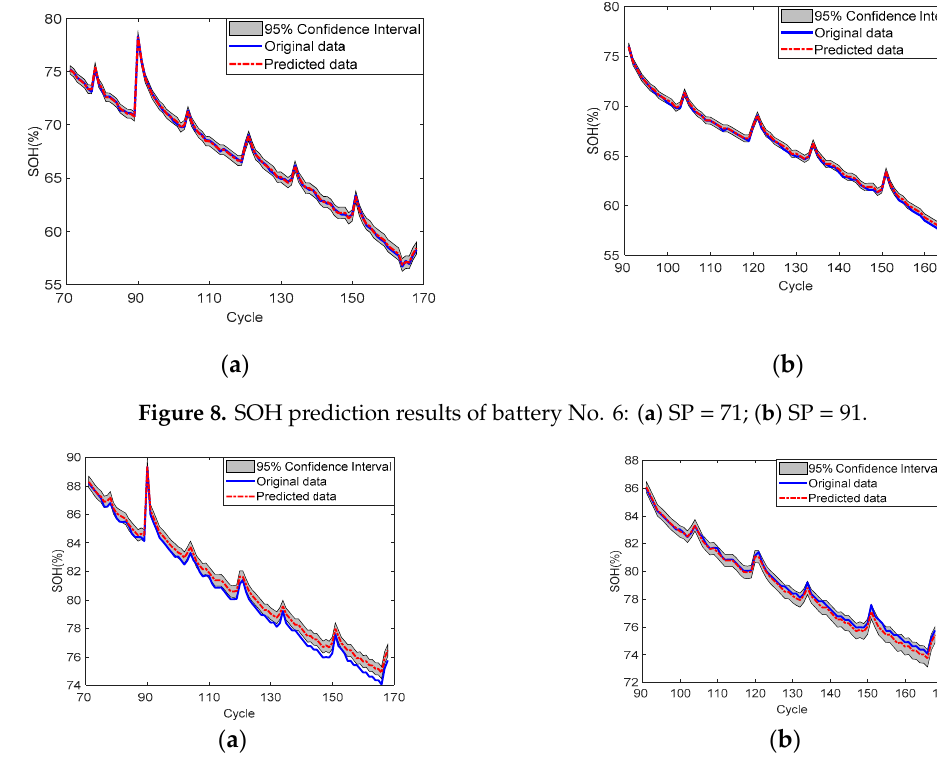
Figure 9. SOH prediction results of battery No. 7: ( a ) SP = 71; ( b ) SP = 91.